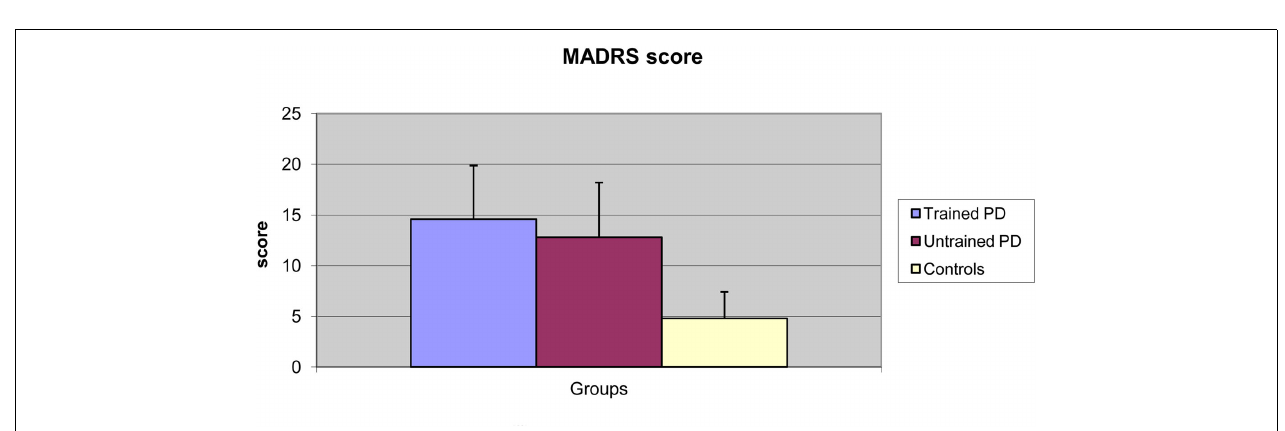
FIGURE 2 | MontgomeryAsberg Depression Rating Scale scores from control subjects and patients (trained and untrained) at the first evaluation demonstrating the significant differences between both groups ( p > 0.001).